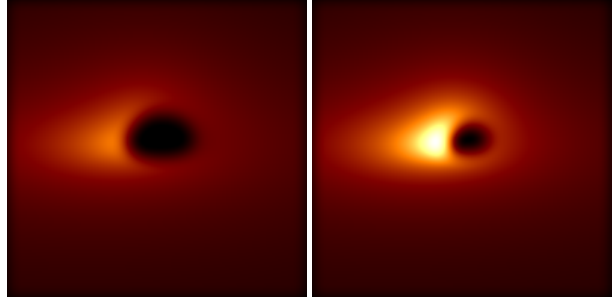
Figure 6. Simulations of accretion discs for an inclination of 60 ◦ and a = 0.6 m. A resolution of 20 µ as was assumed [50]. The left panel shows the result for GR and the right one for pc-GR. As seen, the GR and pc-GR cannot be distinguished clearly. The dark center in GR is slightly larger than in pc-GR, which is also noted in the calculation of fluxes (see main text). The figures were obtained using the open accessible 2014 version of the GYOTO routines [48]. For n = 4, the modified C++ rountines can be retrieved in [45].